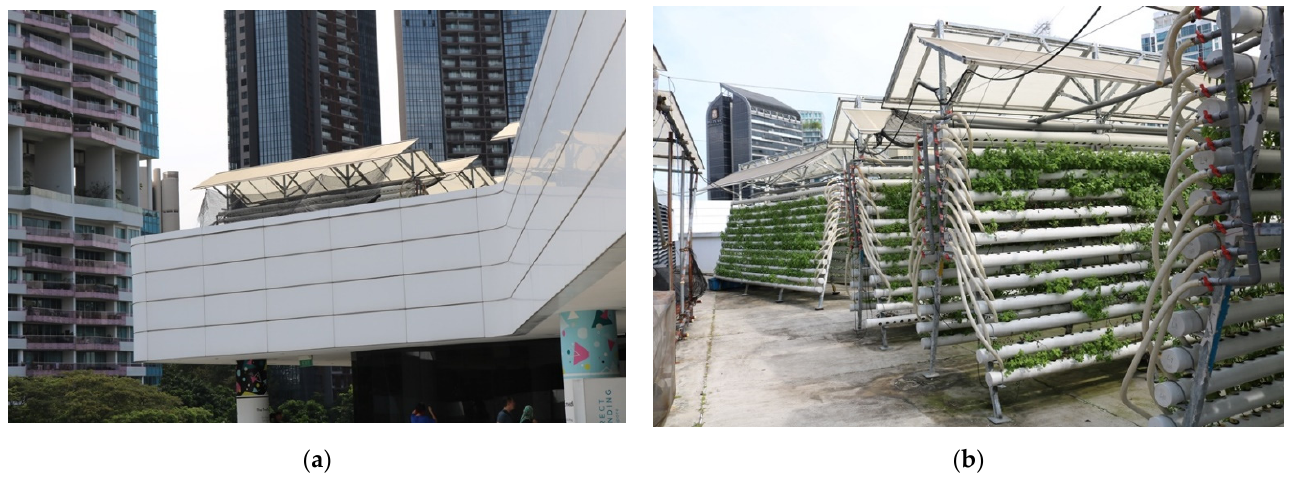
Figure 4. ( a ) Hydroponic modules visible from the ground floor of the *SCAPE building and ( b ) rows of hydroponic modules placed on the rooftop.